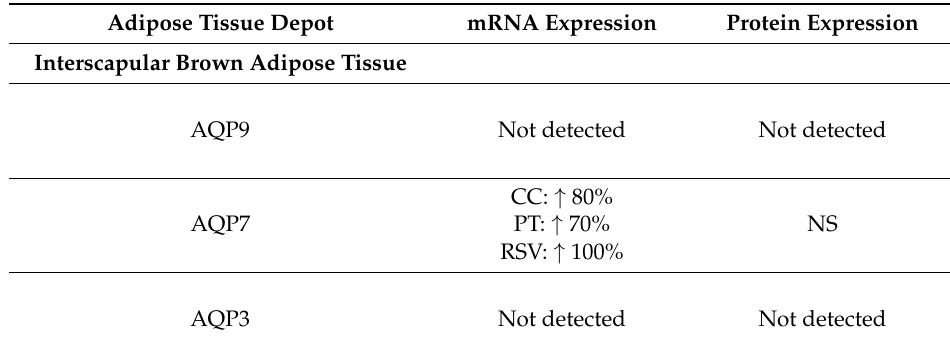
Adipose Tissue Depot mRNA